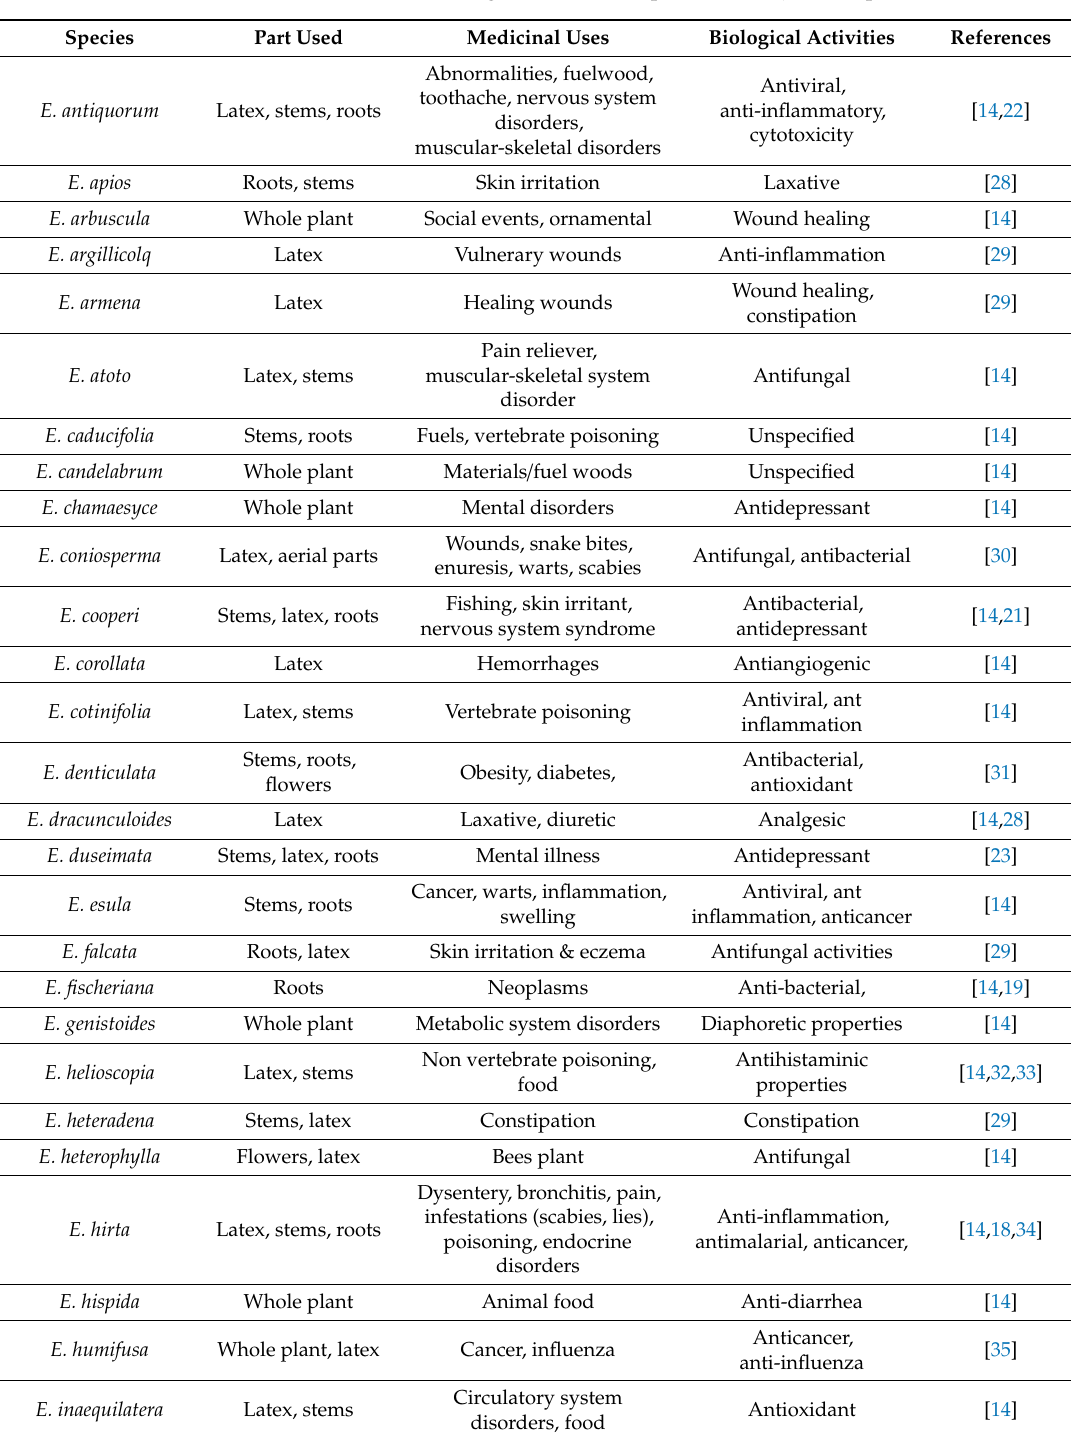
Table 1. Traditional uses and biological activities reported for Euphorbia